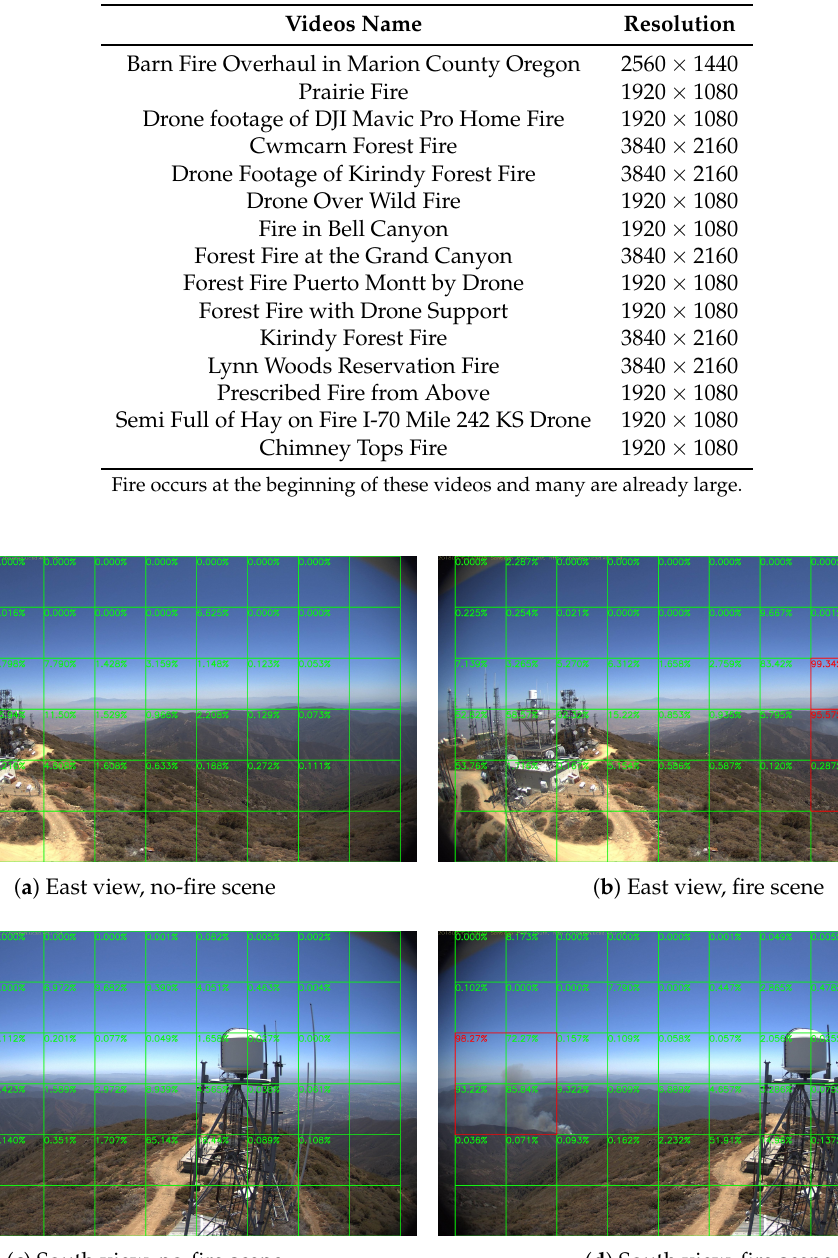
Table 3. Worked YouTube daytime fire video list.